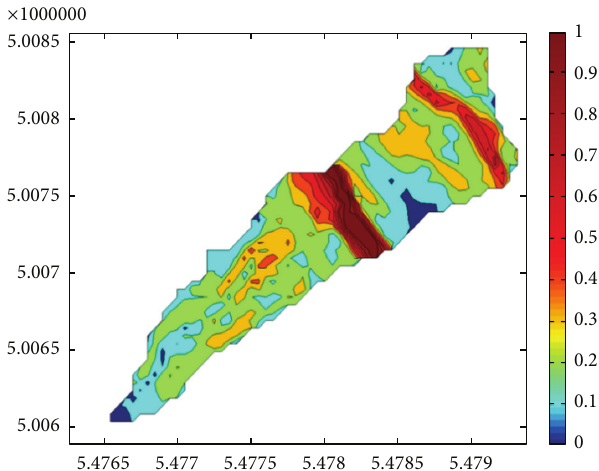
Figure 6: Slope map of the Slani Potok catchment area.